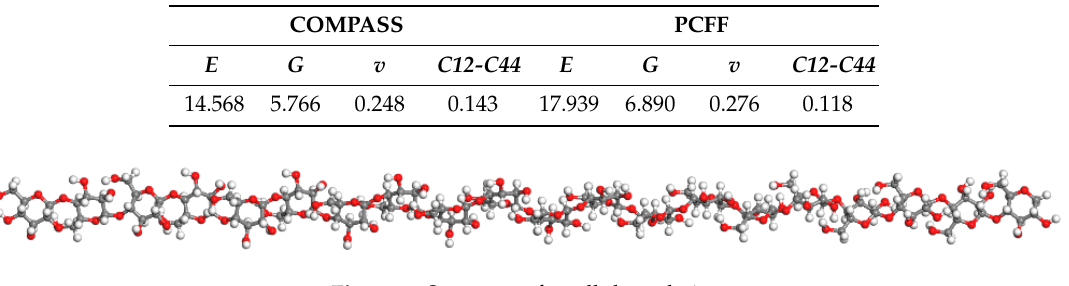
Figure 4. Structure of a cellulose chain.